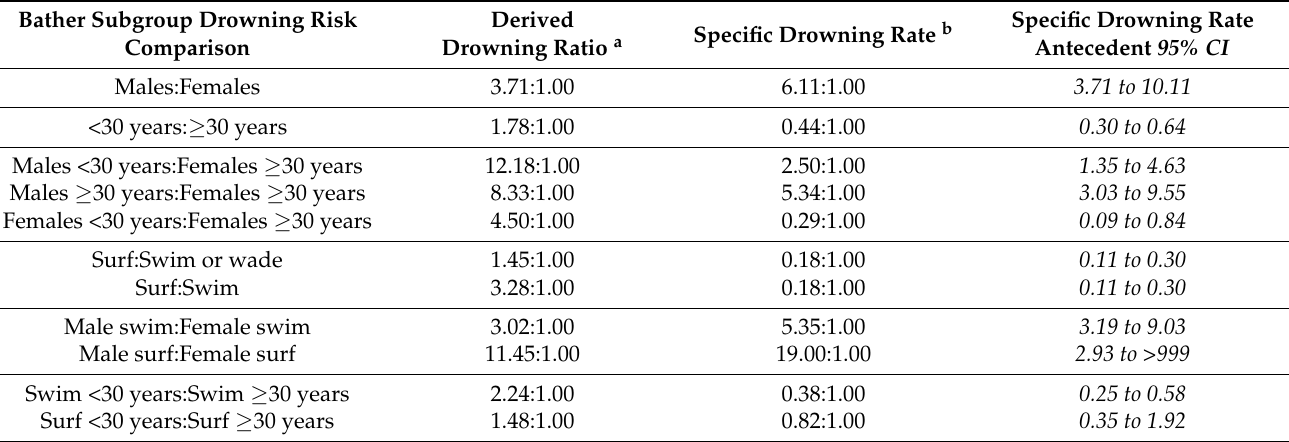
Table 4. Risk analysis drowning ratios and drowning rates.